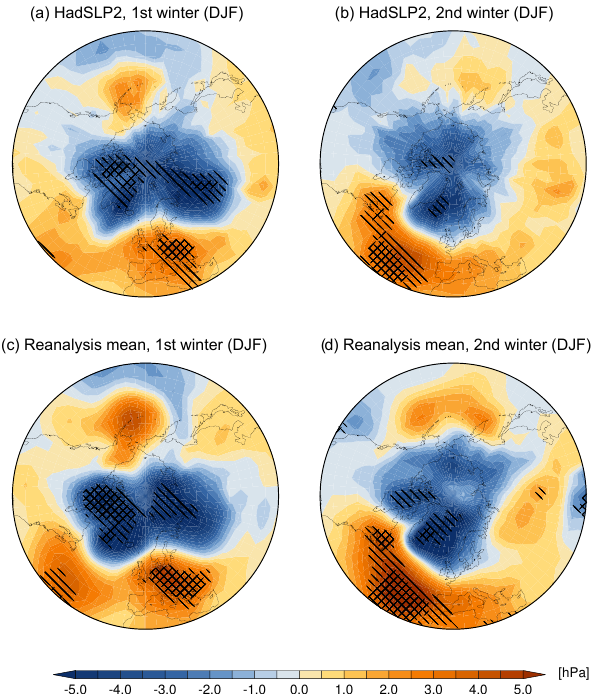
Figure 3. Observed and multi-reanalysis mean SLP anomalies (hPa) in the Northern Hemisphere in the first two post-volcanic win- ters (DJF) averaged over the two volcanic eruptions of Mt Pinatubo (1991) and El Chichón (1982). Anomalies are calculated with re- spect to the mean for the years 1979–2012, excluding the follow- ing 2 years after the eruptions. Single diagonal lines correspond to the 90% and double diagonal lines to the 95% confidence level obtained with a Monte Carlo test of two independent samples. Panel (a) shows the mean anomaly for the HadSLP2 observation data for the first and (b) for the second winter after the eruptions. Panels (c) and (d) show the mean anomaly of all 10 reanalysis datasets (Table